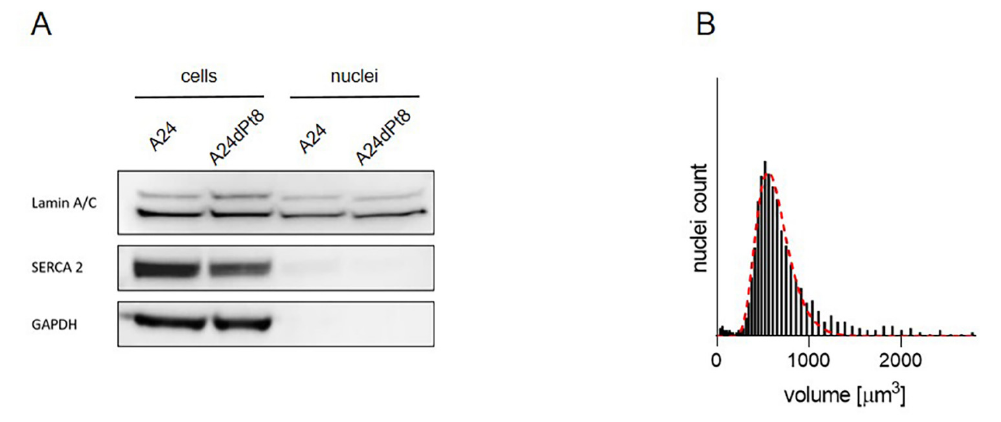
Figure 5. Isolation of intact nuclei. ( A ) The purity of the nuclear fraction was assessed using Lamin A/C (nuclear marker), SERCA2 ATPase (ER marker) and GAPDH (cytoplasmic marker) by Western blot. Column 1 and 2 show the cell extracts of A24 and A24dPt8, column 3 and 4 show the A24 isolated nuclei and the A24dPt8 isolated nuclei. ( B ) Representative volume distribution of isolated nuclei from A24 cells. The red curve shows the lognormal fit of the frequency.